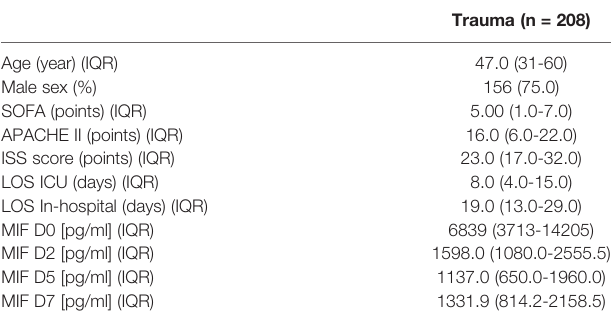
TABLE 1 | Trauma patient clinical